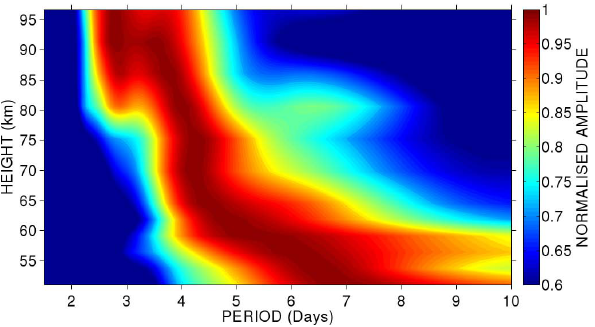
Fig. 10. Normalised wave amplitudes as a function of height for E1 waves in the MLS temperature data averaged over the interval 2005–2010.